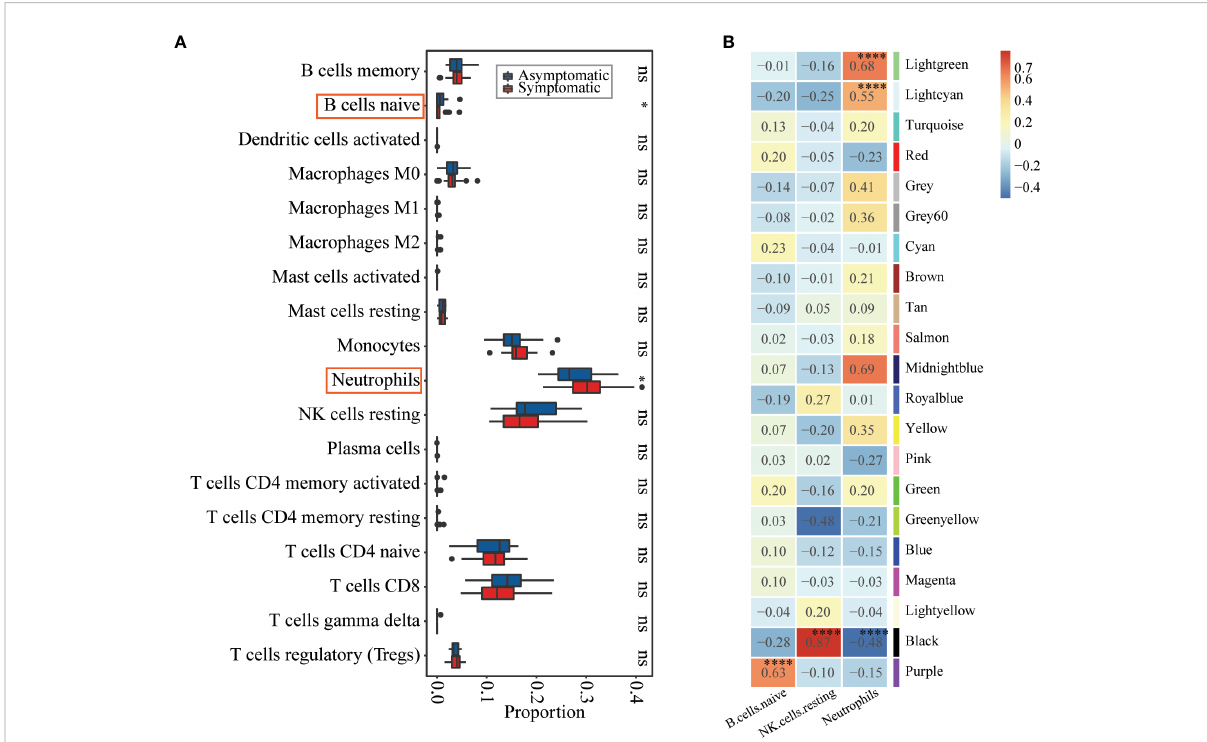
FIGURE 3 Immune cell proportions ’ differences between asymptomatic and symptomatic hosts and their relationships with co-expression modules. (A) Boxplot showing the immune cell proportions in asymptomatic (blue) and symptomatic (red) hosts. Wilcoxon rank-sum test was used to determine signi fi cant differences between asymptomatic and symptomatic hosts. The signi fi cant level was indicated by number of asterisks (ns for p > 0.1, * for p ≤ 0.1, ** for p ≤ 0.01, and *** for p ≤ 0.001) and highlighted by red rectangle. (B) Heatmap of Module-trait ’ s correlation, in which immune cell types on the x-axis against the co-expression modules on the y-axis. The corresponding correlation was shown in the cells and color coded. The signi fi cantly related modules were indicated by number of asterisks (* for p ≤ 0.1 and **** for p ≤ 0.0001) and highlighted by red